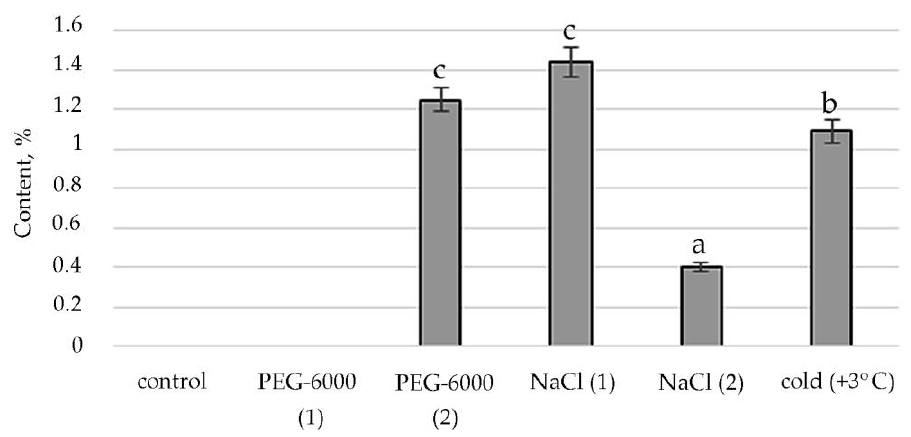
Figure 5. Change in content of phytol in S. hybridum under stress conditions. Values presented are means (±SD). Different letters above the bars represent significant differences at p ≤ 0.05, n = 3 plants in each of 3 replicates for all treatments.